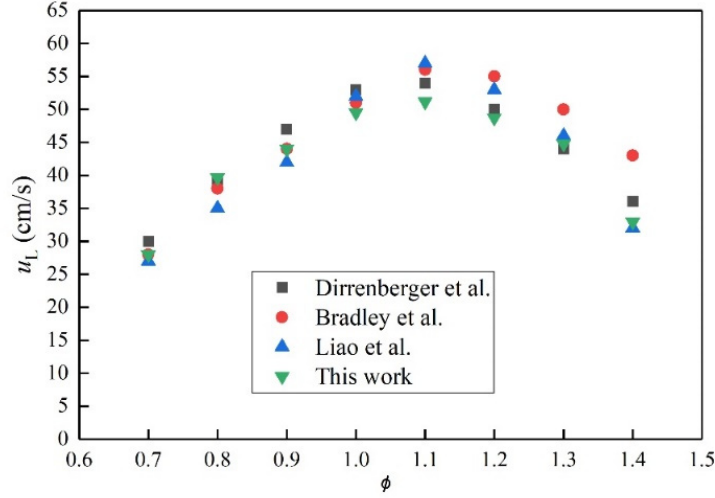
Figure 2. Comparison of 𝑢 (cid:3013) of ethanol in this work and other researchers’ results.